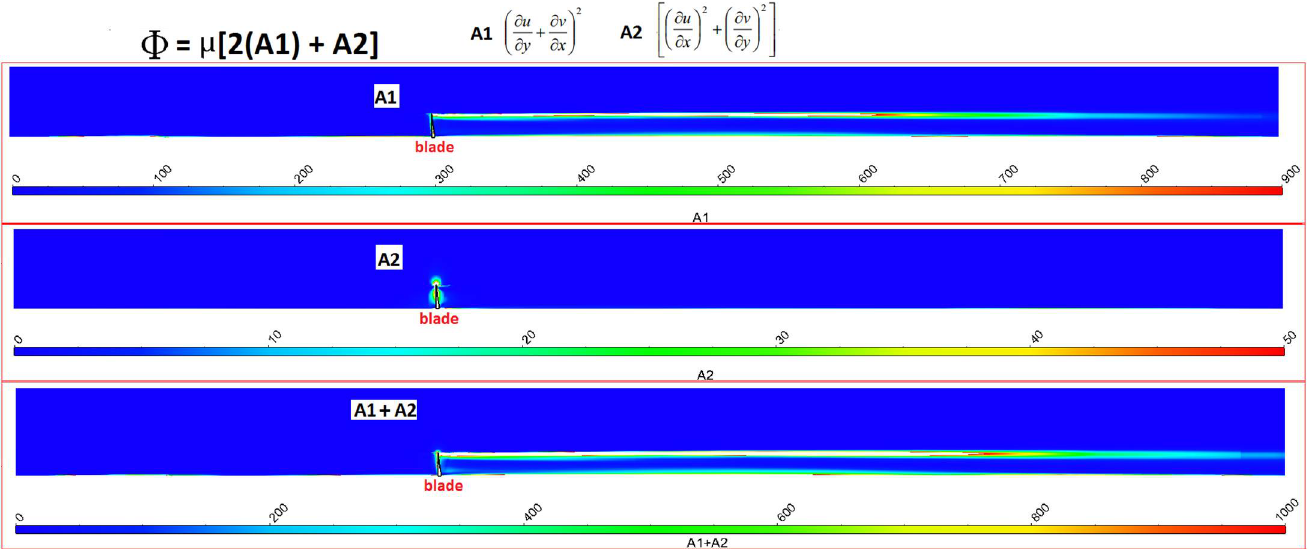
Figure 24. Dissipation function terms calculated for 3X [15R-15R-30R] domain in azimuthal view, A1 is the shear-stress term (dominant) and A2 is the velocity gradient.